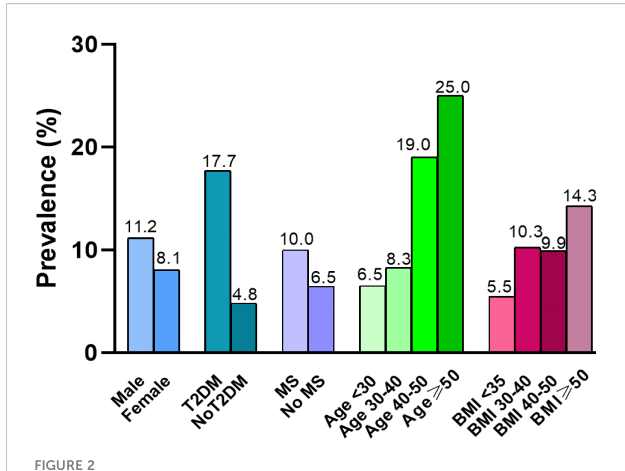
FIGURE 2 Prevalence of signi fi cant fi brosis strati fi ed by gender, age, T2DM, MS and BMI.